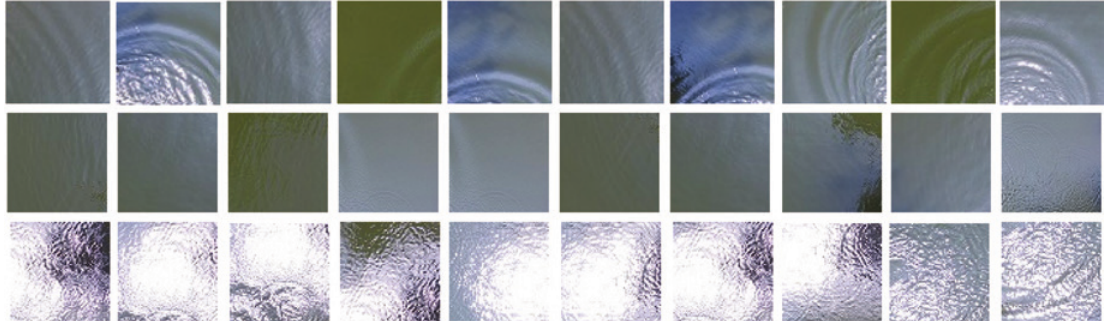
Figure 5: Image patches of three types of simulative wave samples. First row represents positive samples, second row repre- sents the negative samples and third row represents the noises.